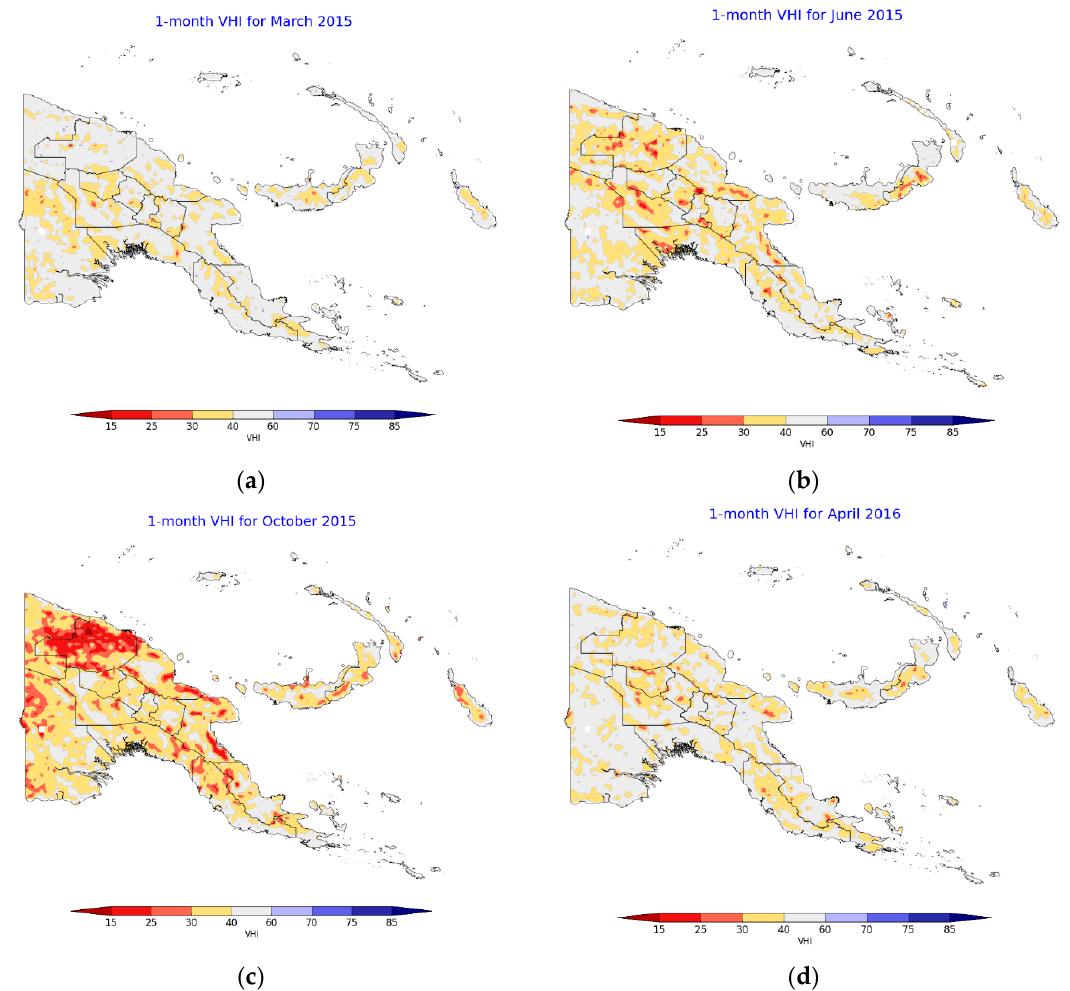
Figure 12. Vegetation Health Index (VHI) values showing the progression of the 2015–2016 drought event. ( a ) March 2015 showing largely neutral vegetation health; ( b ) June 2015 showing the beginning of below-average vegetation health; ( c ) October 2015 showing widespread areas of poor vegetation health; ( d ) April 2016 showing easing of poor vegetation health.